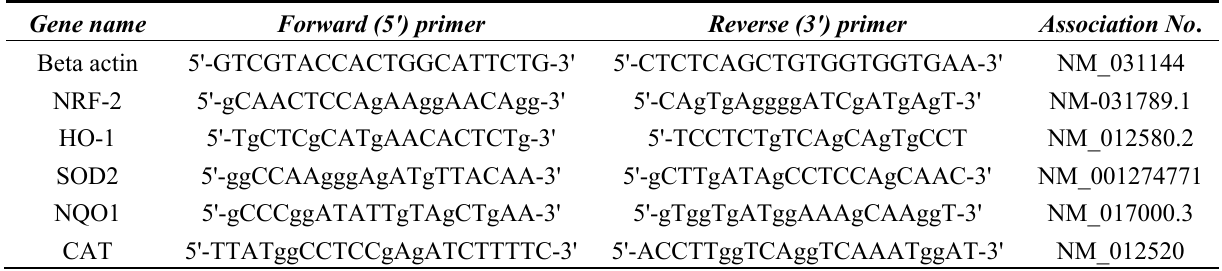
Table 1. PCR primers used in the gene expression